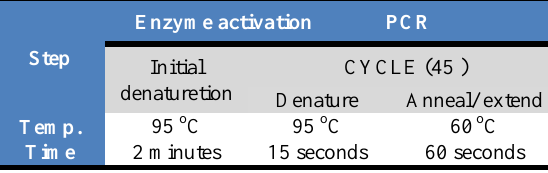
Table, 1: Real time PCR program.